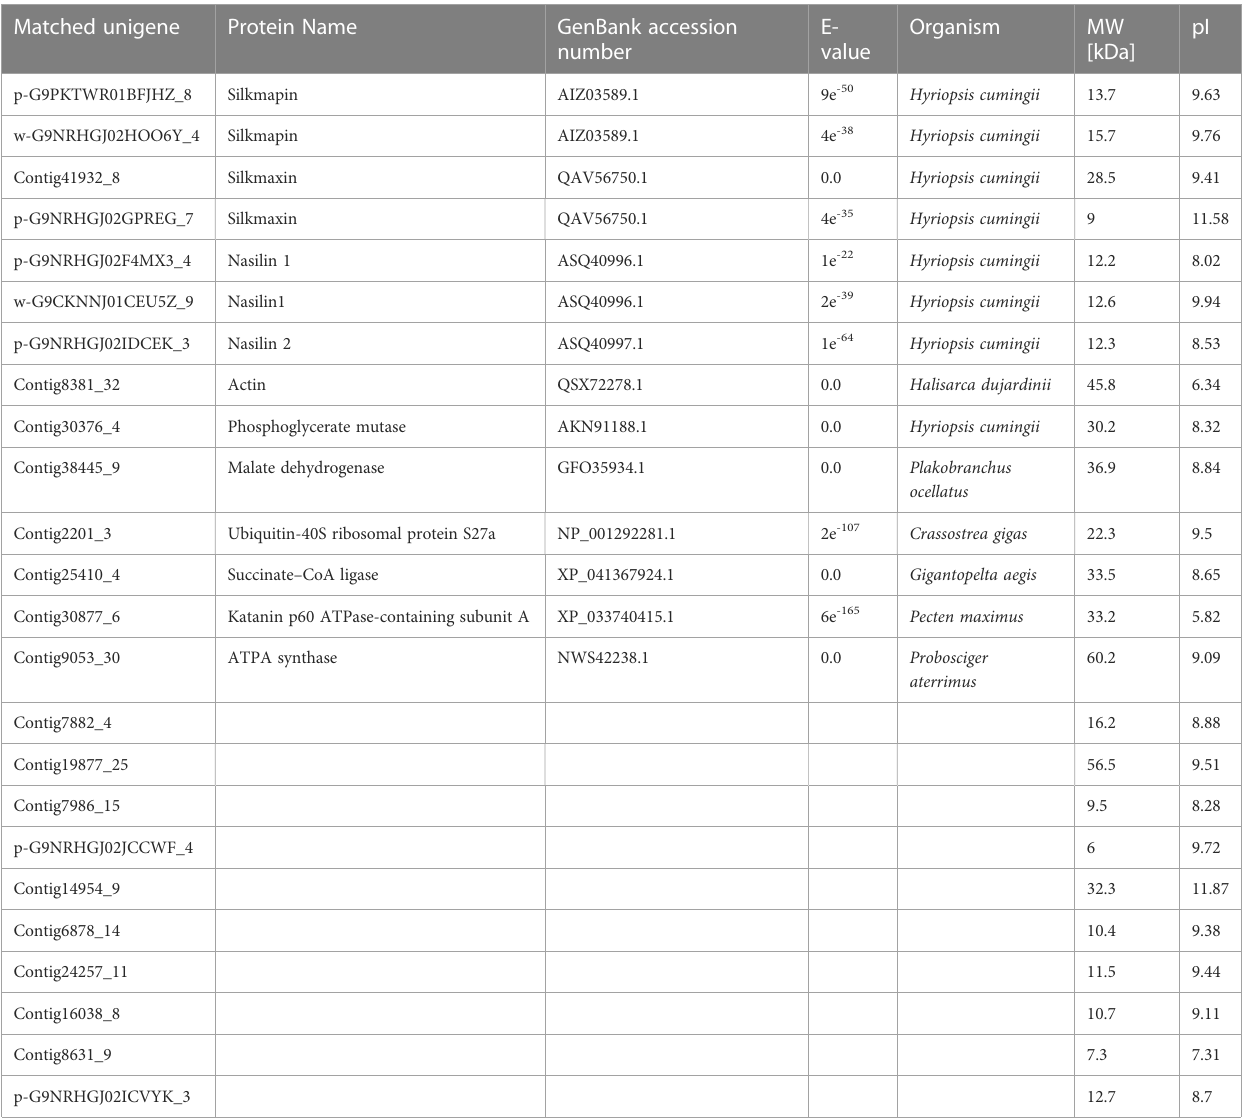
TABLE 2 Matrix proteins identi fi ed from the prismatic layer of Hyriopsis cumingii . Matched unigene Protein